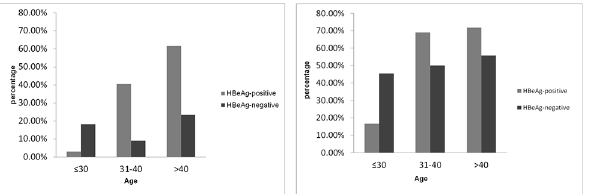
Fig 3. Distribution of significant hepatic histopathology among different age subgroups. (A) Significant necroinflammation ( (cid:3) G2) occurred in 3.1% of subgroups of patients (cid:1) 30 years, 40.5% in 31 – 40 years and 61.5% in > 40 years in HBeAg-positive patients, respectively; and in 18.2% of subgroups of patients (cid:1) 30 years, 9.1% in 31 – 40 years and 23.5% in > 40 years in HBeAg-negative patients, respectively. (B) Significant fibrosis ( (cid:3) S2) was found in 16.7%, 69.1% and 71.8% of HBeAg-positive patients in the age subgroups of (cid:1) 30, 31 – 40 and > 40, respectively, of and in 45.5%, 50.0% and 55.9% of HBeAg-negative patients in the age categories of (cid:1) 30, 31 – 40 and > 40, respectively. Significant differences in necroinflammation (P < 0.001) and fibrosis (P < 0.001) occurred among subgroups of HBeAg-positive patients. HBeAg-positive patients over 30 years showed much higher percentages of significant histologic abnormalities than those (cid:1) 30 years of age (P <